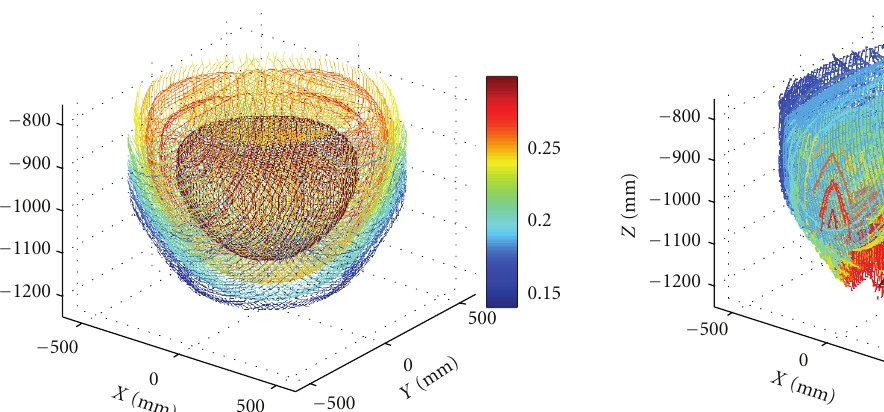
Figure 2: Manipulability index μ t .